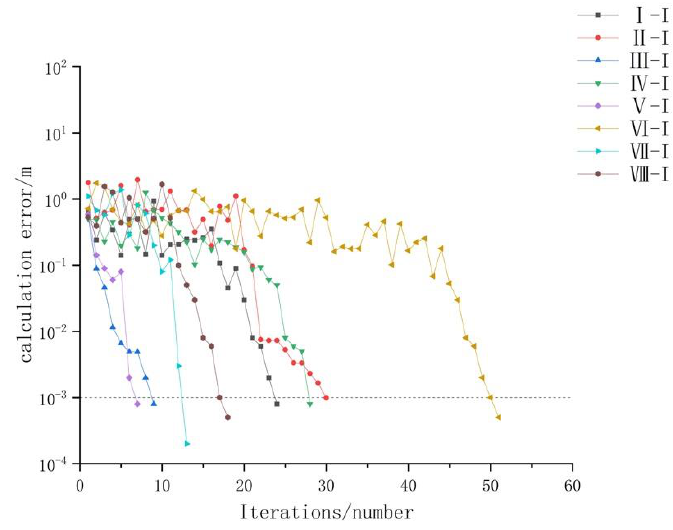
Figure 6. Comparison of two algorithms. Table 5. Multiple working